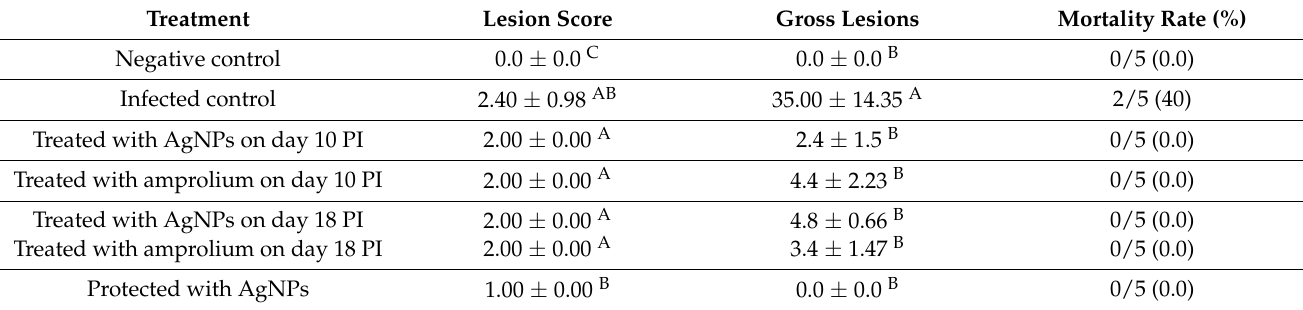
Table 5. Effectofthedifferenttreatmentsonthemeanvaluesofthelesionscore, grosslesions,